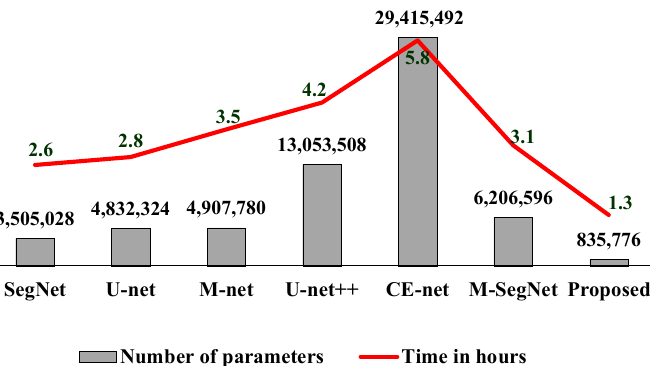
Figure 8. Comparison of the proposed and conventional methods in terms of the number of trainable parameters and computation times.